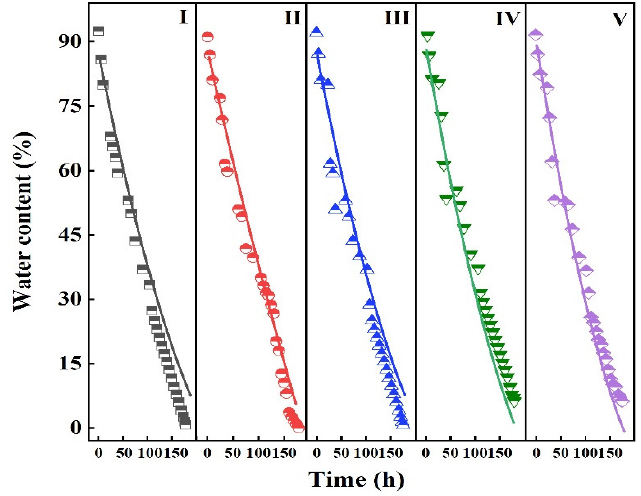
Figure 10. Effect of cyclic water absorption and release of ceramsite .